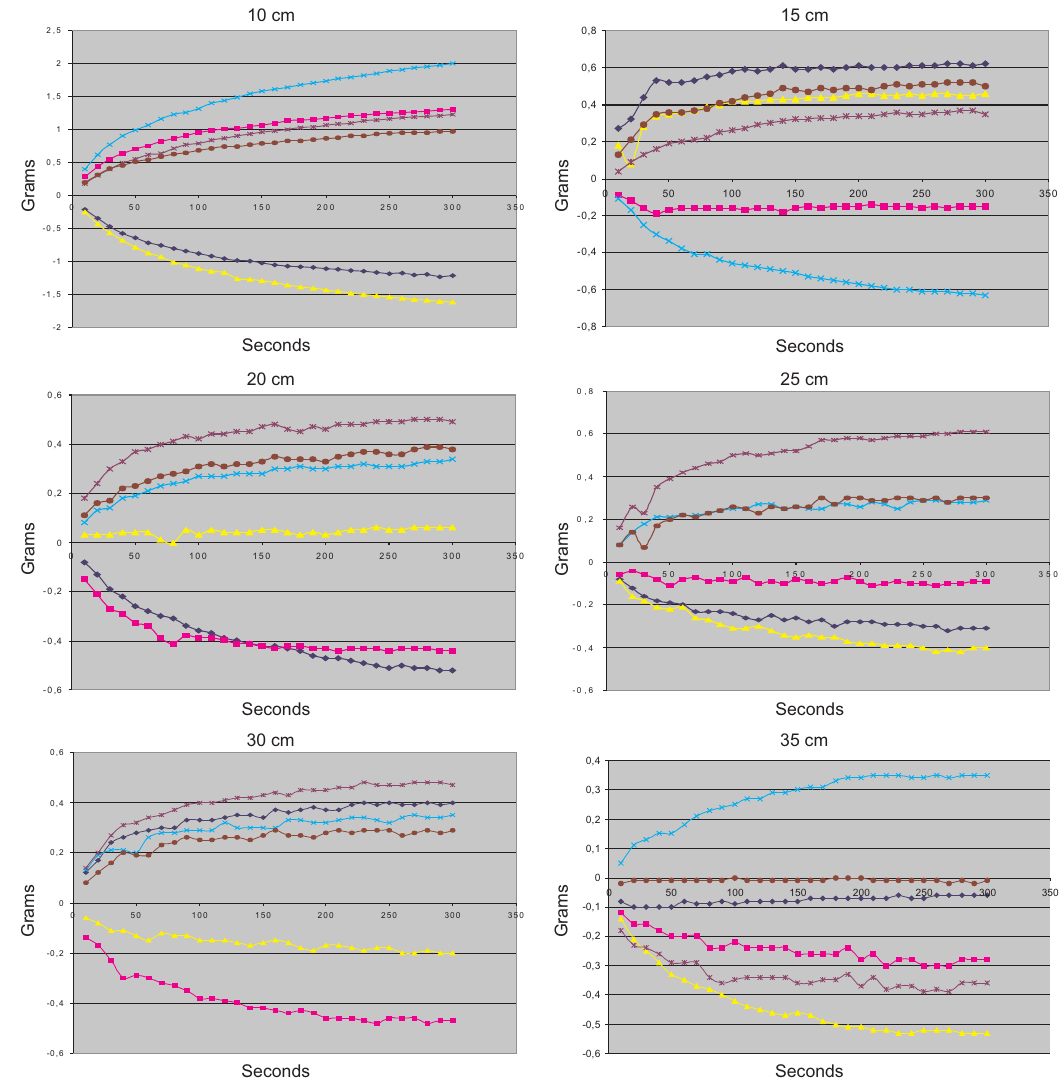
Figure 7. Behavior of the device during the five minutes just after the commercial urine meter was set up. Different tube lengths are